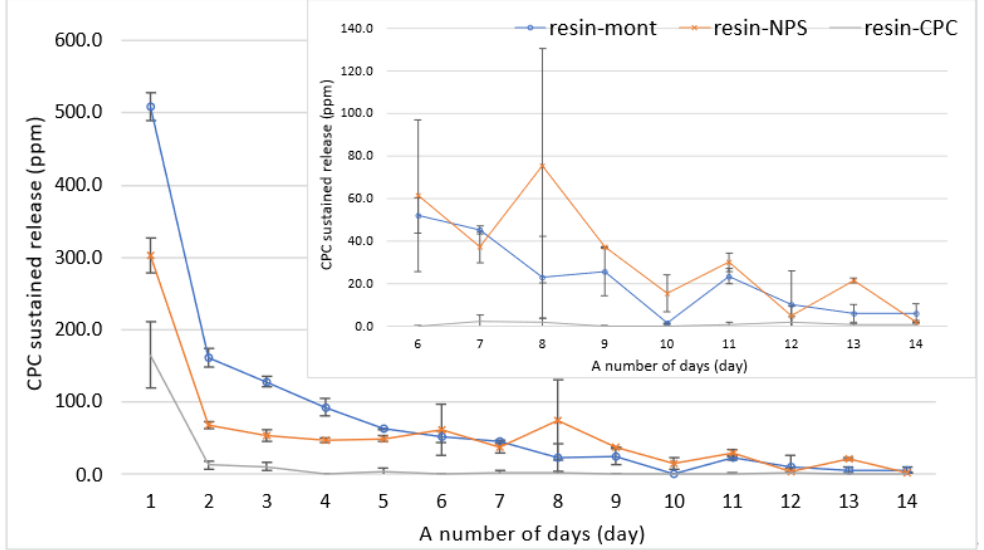
Figure 2. Amount of released CPC from resin-Mont, resin-NPS, and resin-CPC. The inside graph is zoomed in on days 6 through 14.